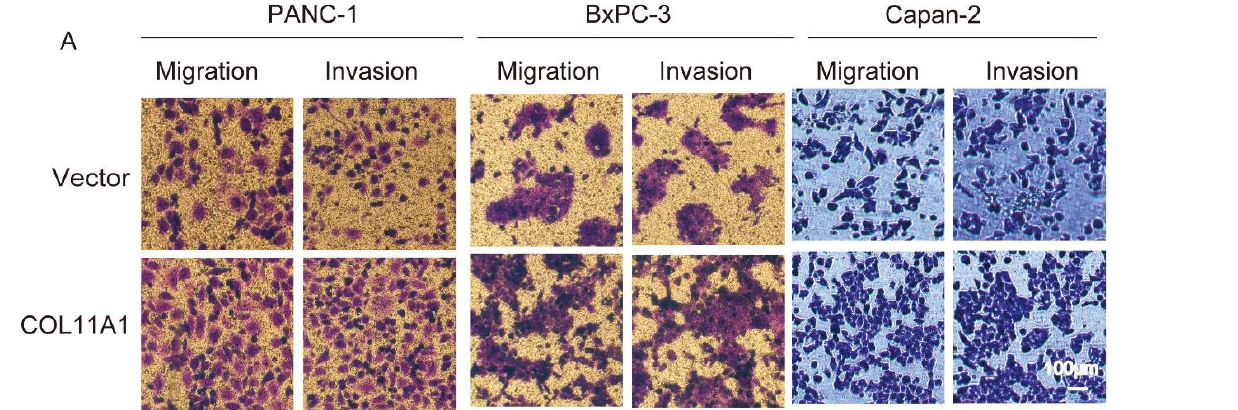
Figure 1. Collagen type XI α1 (COL11A1) promoted the migration and invasion abilities of pancre- atic cancer cells: ( A ) overexpression of COL11A1 induced by pCMV3-COL11A1 promoted the mi- gration and invasion of Capan-2, BxPC-3, and PANC-1 cells; ( B ) small interfering (si)-COL11A1 inhibited the migration and invasion of PANC-1, BxPC-3, and Capan-2 cells; ( C ) the number of in- vasive and migrated pancreatic cancer cells treated with pCMV3-COL11A1 or siCOL11A1(n = 3, * p < 0.05). 3.2. COL11A1 Modulated the EMT-likePhenotypic Changes and Matrix Metalloproteinase (MMP)-2/9Expression Levels To examine the underlying mechanism by which COL11A1 promotes the invasion and migration of pancreatic cancer cells, we measured the expression levels of EMT mark- ers and MMP-2/9 using Western blotting and immunofluorescence. Western blotting re- sults revealed that pCMV3-COL11A1-transfection upregulated the expression levels of N- cad, VIM, and MMP-2/9 but reduced the expression of E-cad, in BxPC-3, Capan-2, and- PANC-1 cells. In addition, the knockdown of COL11A1 caused the opposite result (Figure